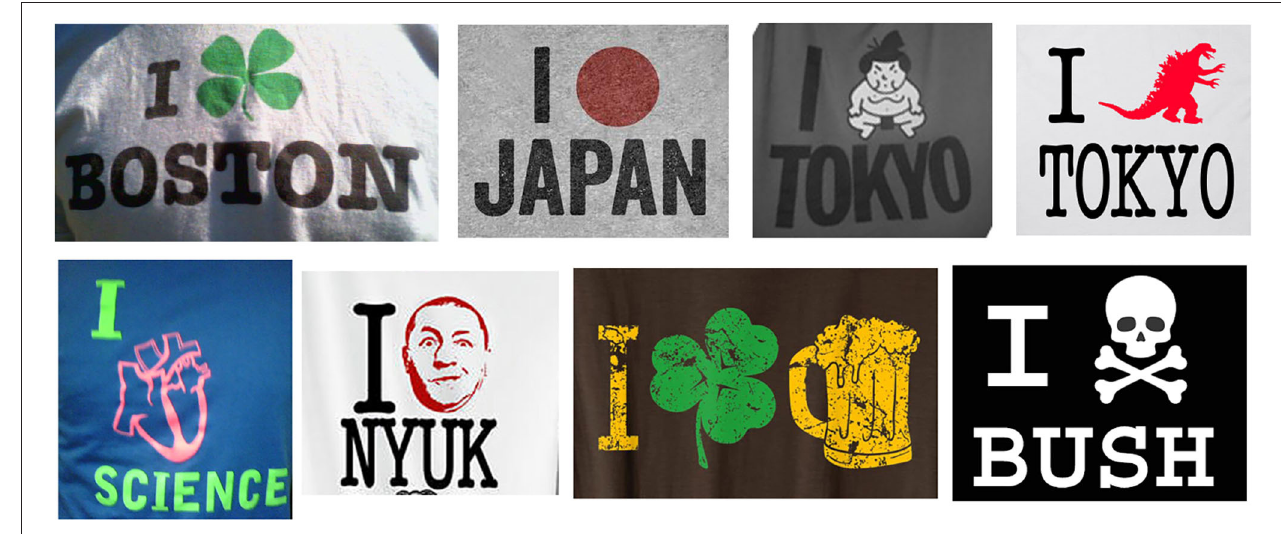
FIGURE 1 | T-shirts all using a pattern of Subject—Picture Verb